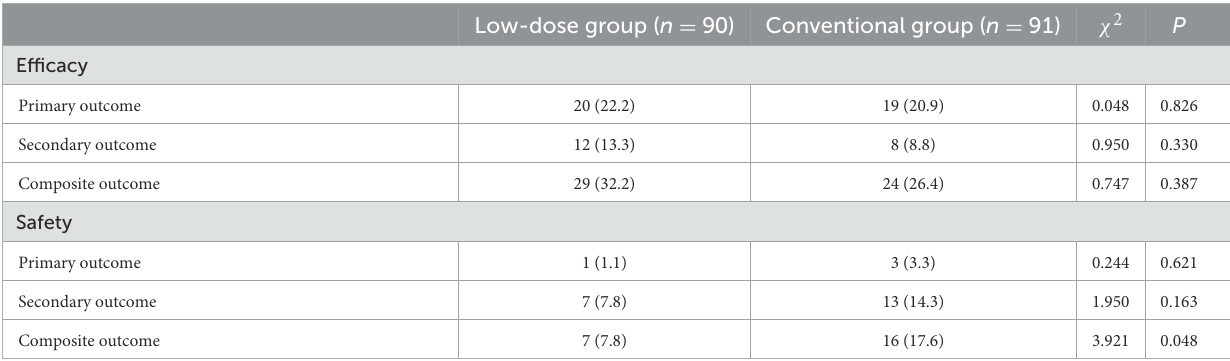
TABLE 4 Efficacy and safety outcomes of comparison low dose and conventional at 24 months ( n ,